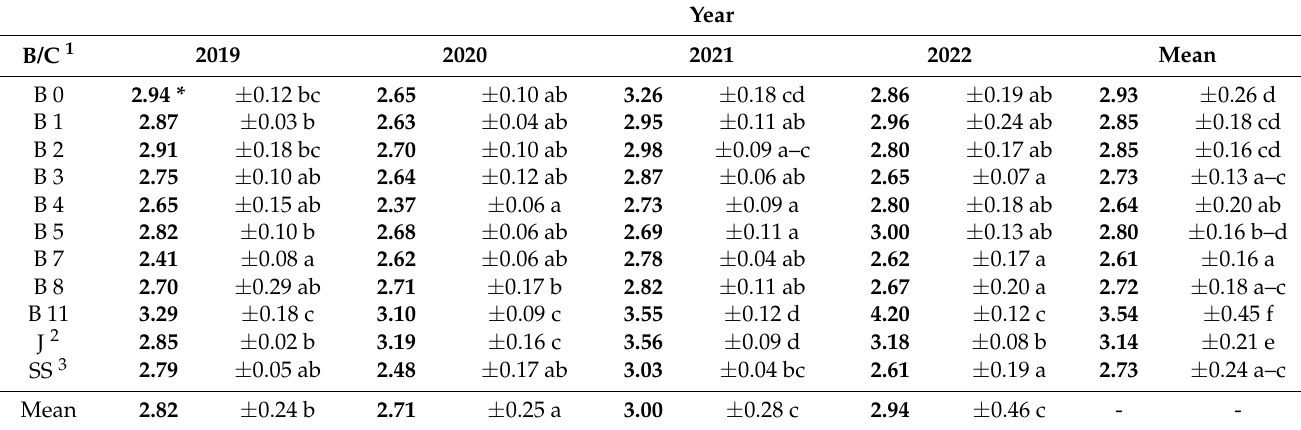
Table 9. Seed length to width ratio of Elaeagnus multiflora biotypes and